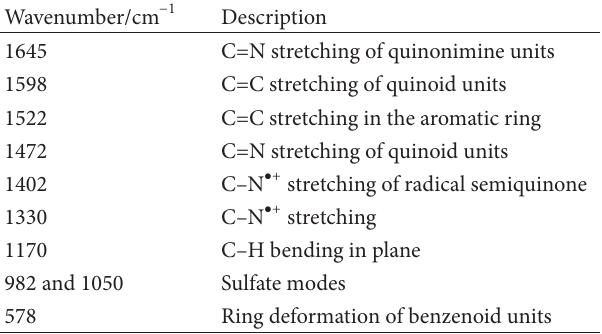
T 4: Vibration modes observed by Raman spectroscopy in POAP-modi�ed Au electrodes at 0.1V in 1MHClO Wavenumber/cm